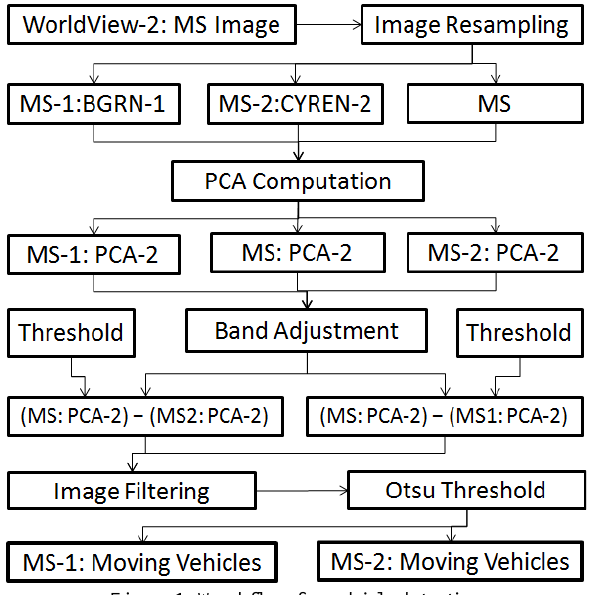
Figure 1: Workflow for vehicle